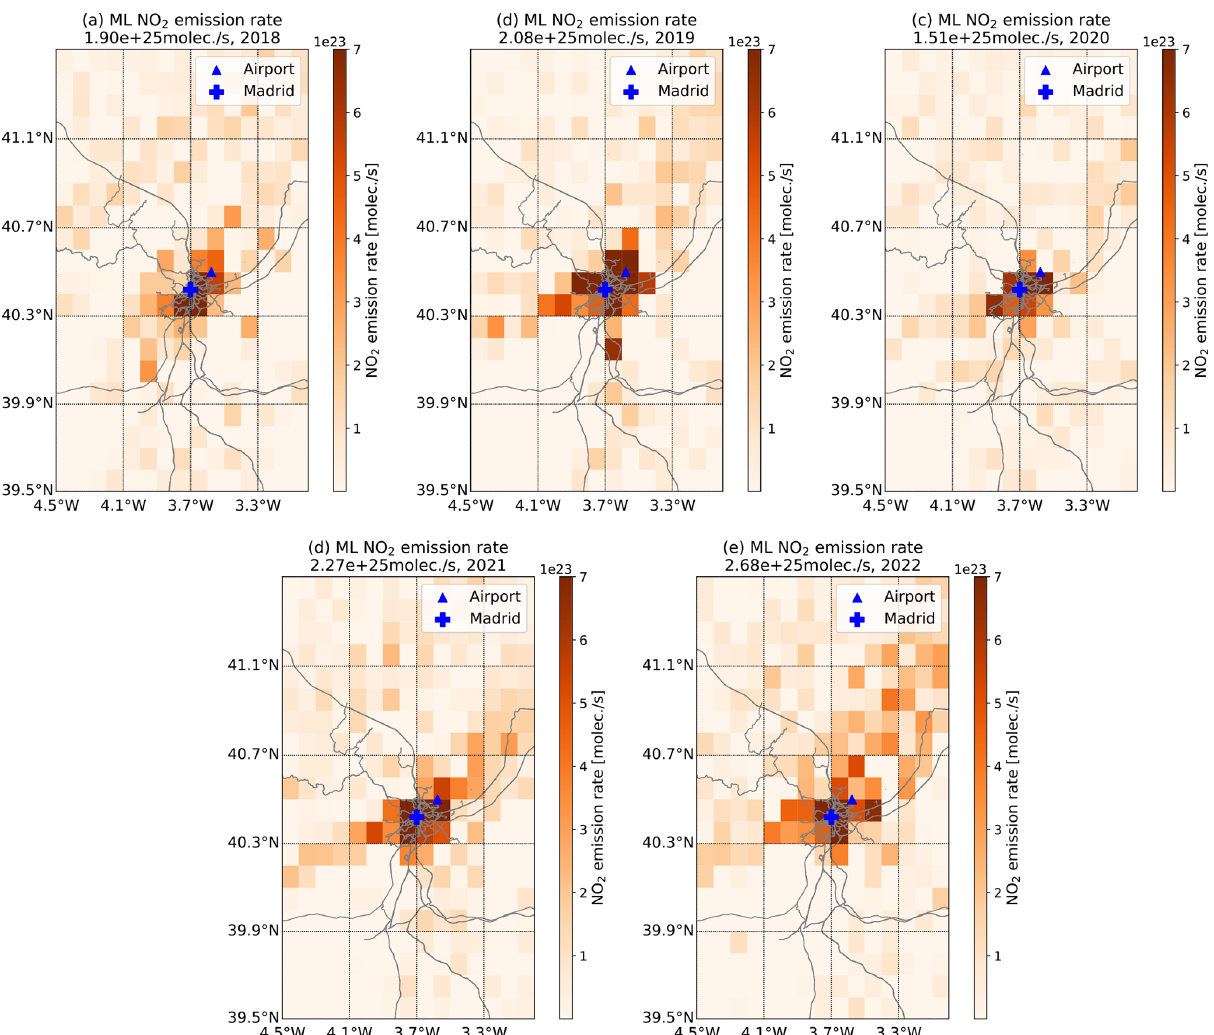
Figure A5. Similar to Fig. A4 but for the Madrid